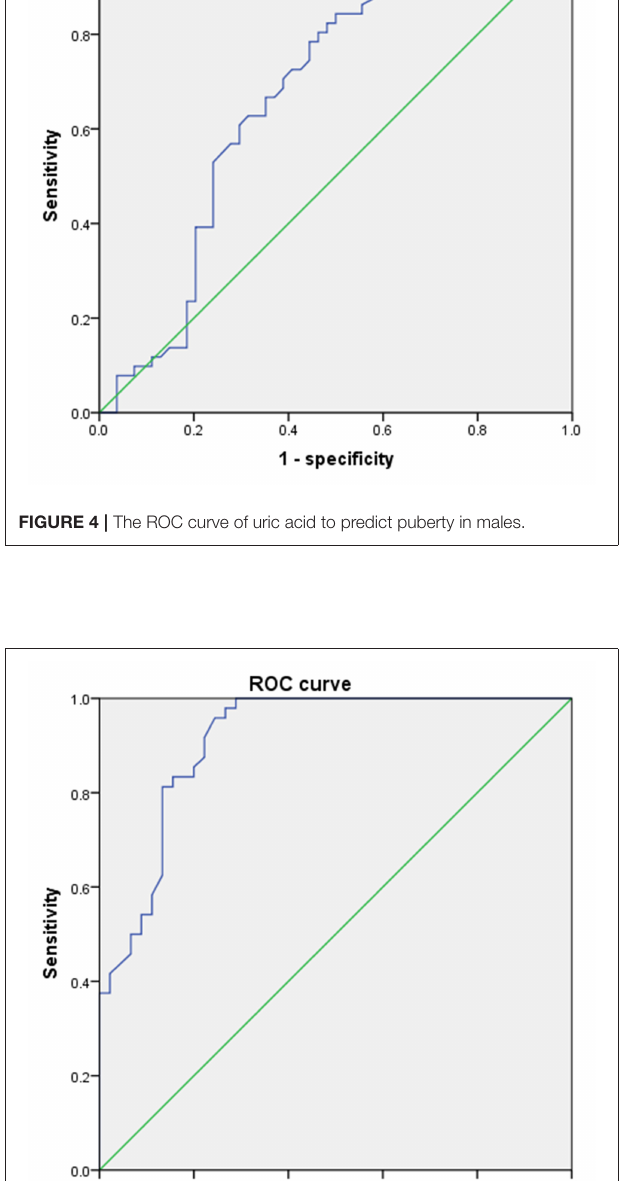
males was 109.321 + BMI ∗ 7.69 + age (year) ∗ 7.76 (R 2 = 0.216, P < 0.001), and 177.848 + BMI ∗ 5.623 + age (year) ∗ 2.407 in females (R 2 = 0.072, P < 0.001).